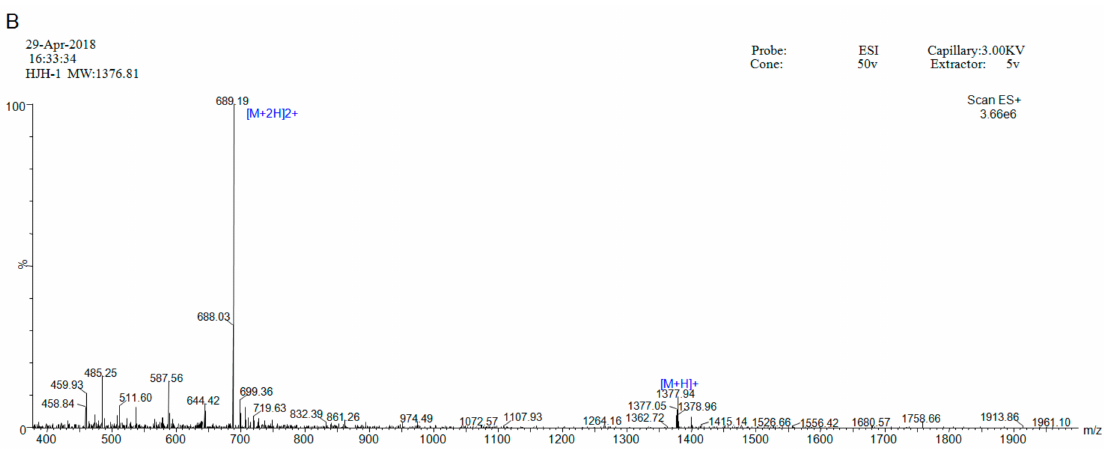
Figure 1. Characterization of AMP HJH-1: ( A ) purification of AMP HJH-1; and ( B ) electrospray